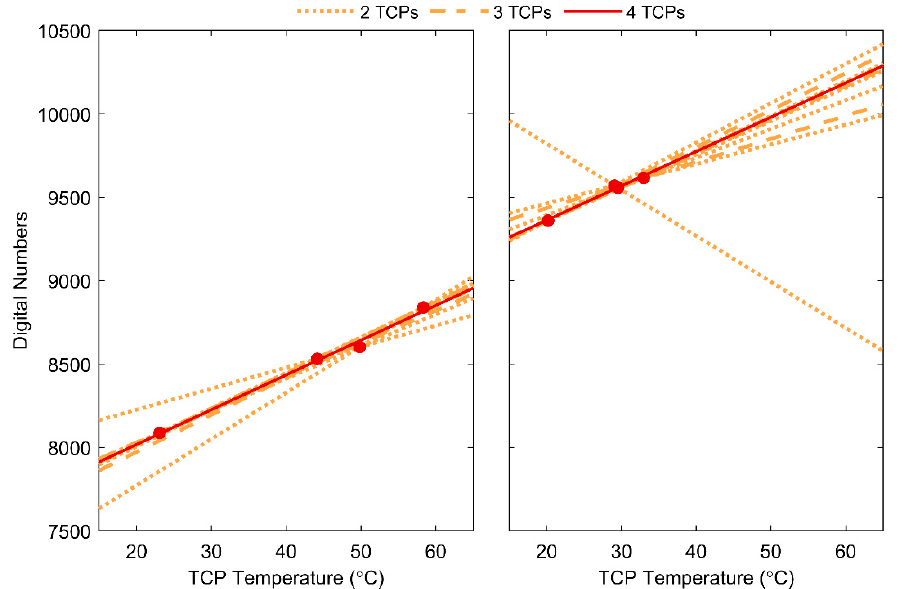
Figure 8. Sensitivity analysis of the TCP calibration for Flights A ( a ) and B ( b ). Each flight included four TCPs (red circles, error bars not shown as σ <41 DN and <0.97 ◦ C, red regression line). The sensitivity of the regression between TCP temperature and DN was tested by plotting regression lines using only two (dotted line) or three (dashed line) TCPs instead of the original four. Table 3. Deviation of mean orthomosaic temperature from the original (‘4 TCP mean’) when calculated using three or two TCPs, respectively. Max 3(2) ∆ = maximum difference in mean temperature between ‘4 TCP mean’ and mean calculated using 3(2) TCPs. Min 3(2) ∆ = minimum difference in mean temperature between ‘4 TCP mean’ and the mean calculated using 3(2) TCPs. All numbers are absolute